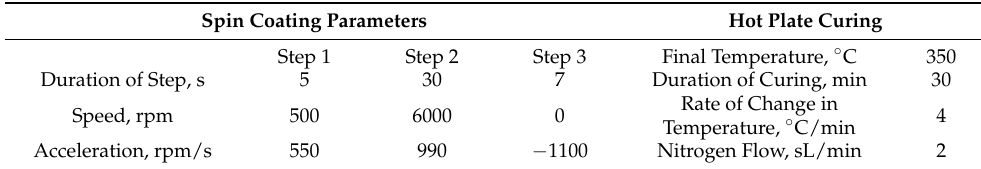
Table 1. Parameters for spin-coated deposition and curing of PI blocking layer [22].